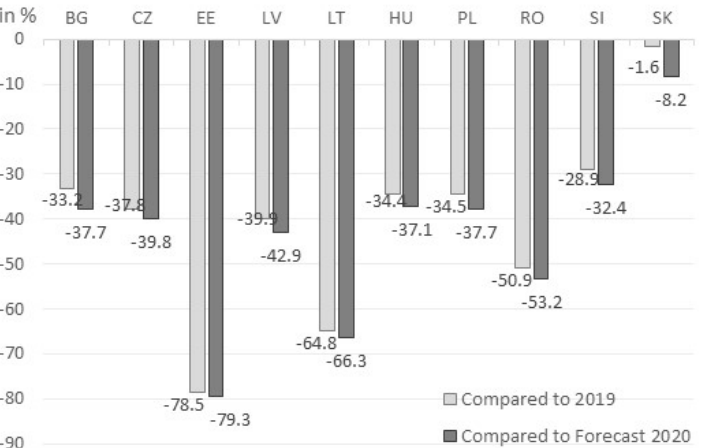
Figure 2. Change in Central and Eastern European countries’ GHG emissions in 2020 with real GDP compared to 2019 and to 2020 (with GDP growth in 2020 consistent with European Commission projection). Source: based on Tables 3 and 4.